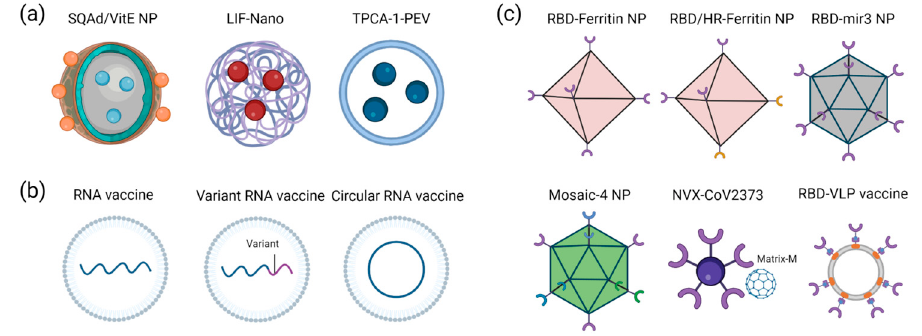
Figure 2. NP-based immunotherapy against SARS-CoV-2. ( a ) NPs for treating cell cytokine storm: an NP containing squalene, adenosine, and Vitamin E, encapsulated LIF within PLGA, platelet-derived extracellular vesicles loaded with TPCA-1. ( b ) Nucleic acid vaccines: NP-based RNA vaccine, variant RNA vaccine, and circular RNA vaccine. ( c ) Protein NP vaccines: the S protein fragments of the virus were attached to different NPs.